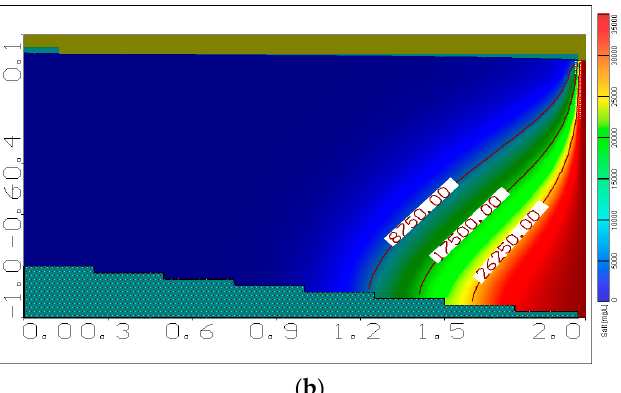
Figure 7. Saltwater intrusion for different bed slope toward the land side ( a ) 20:1 and ( b ) 10:1 .